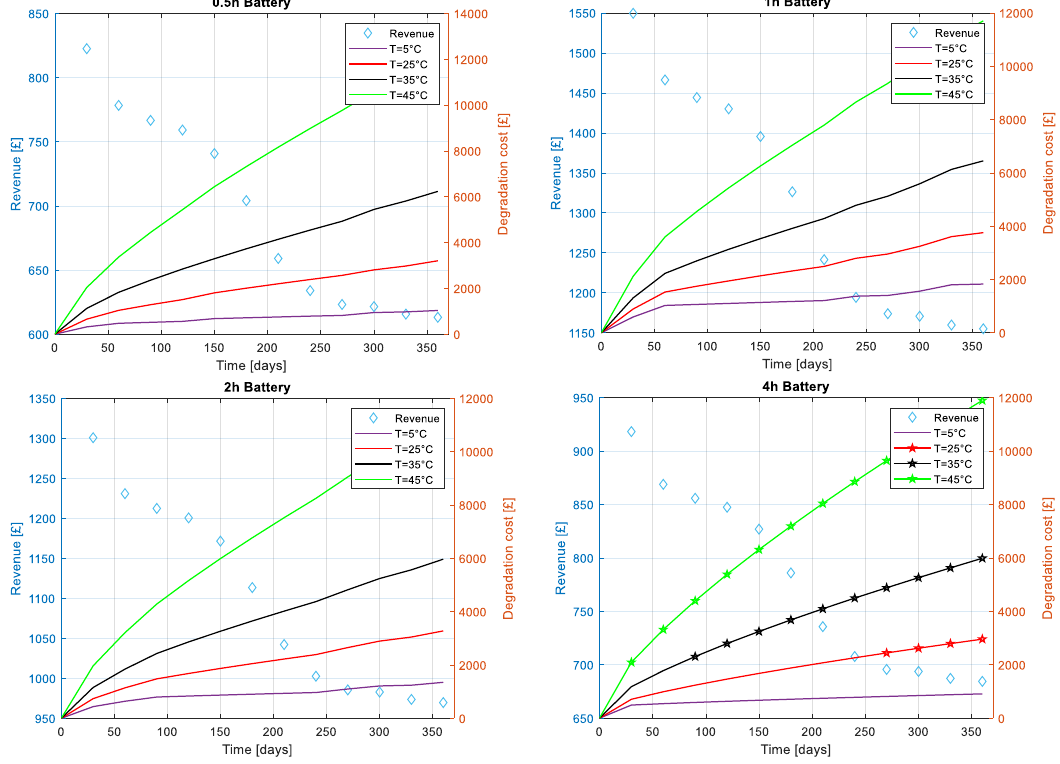
Figure 8. Revenue and degradation cost for 0.5 h - 4 h batteries for several temperatures at 100%SoC. * means a penalty is applicable on this battery at this time. Capacity fade is predicated by Formula (18).